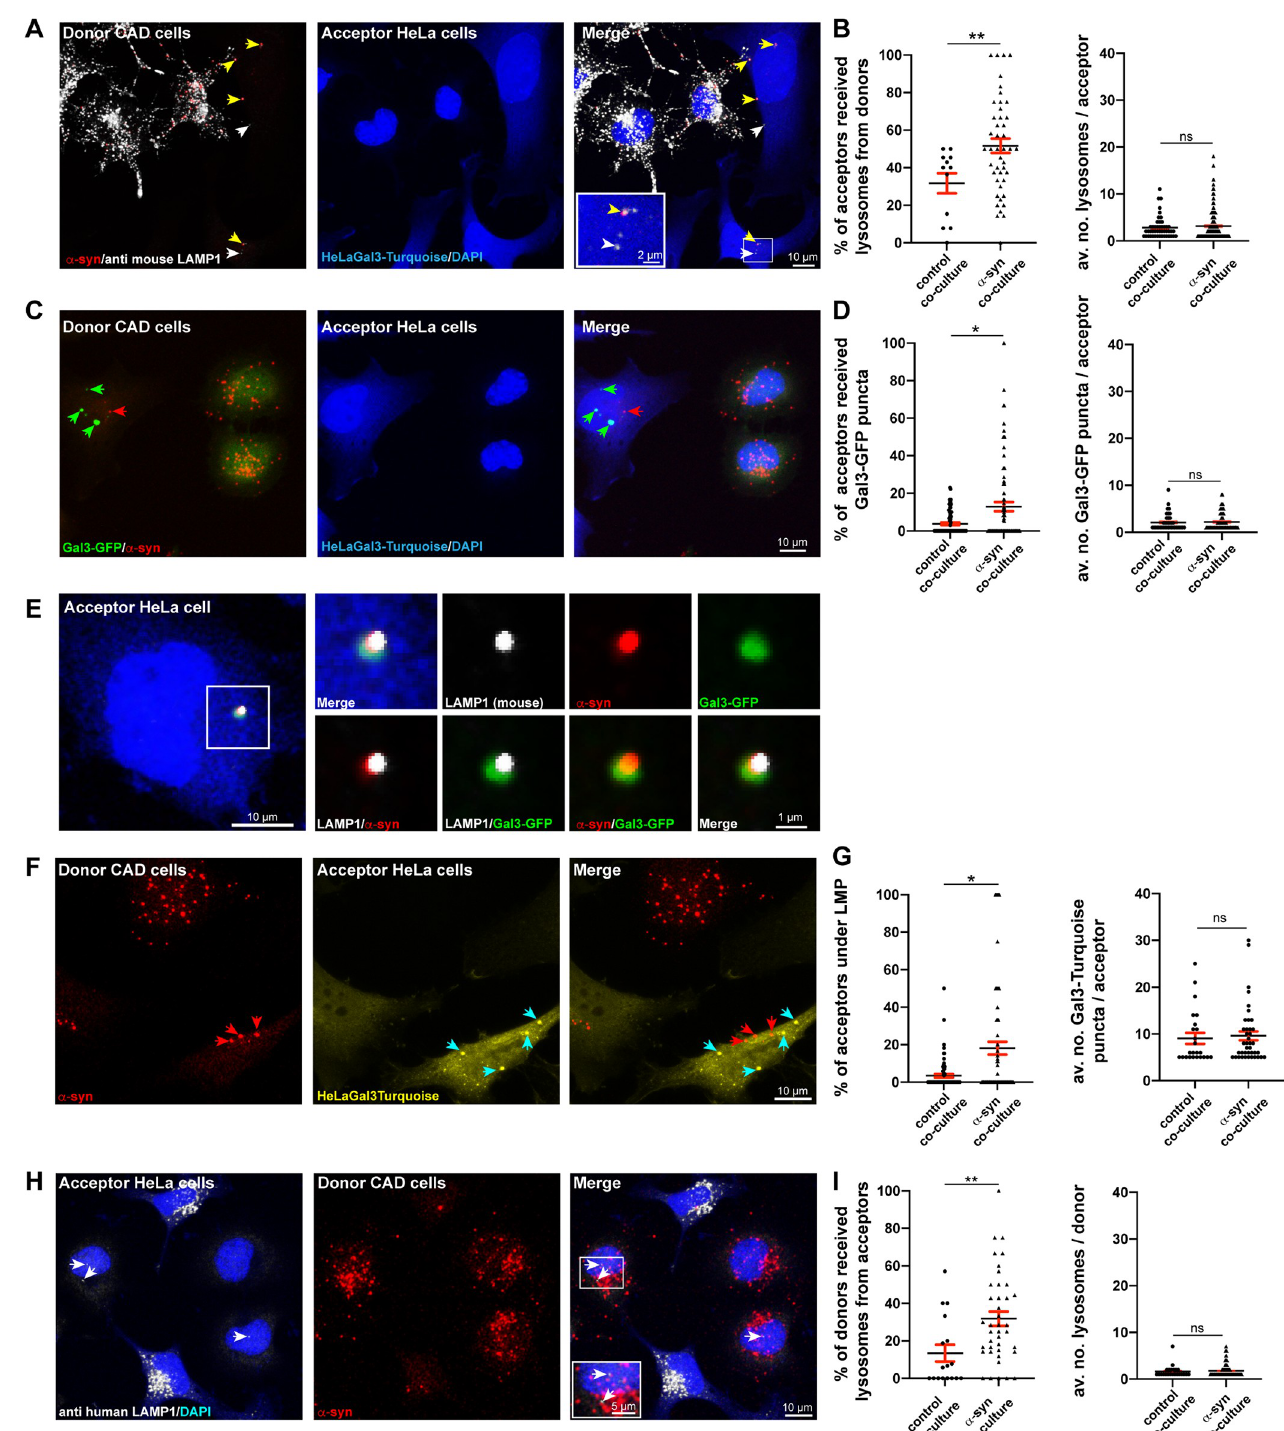
Fig 10. Intercellular lysosome transfer is reciprocal. (A) Representative confocal image of CAD-HeLa coculture where donor mouse CAD cells were treated with Alexa 568–tagged α -syn fibrils (18 hours) and cocultured with acceptor human HeLa stable Gal3-Turquoise cells for 24 hours, labeled for anti-LAMP1 mouse antibody and DAPI. In acceptor HeLa Gal3-Turquoise cells, arrows indicate donors’ lysosomes containing (yellow) or not (white) α -syn fibrils. Inset represents a selected region (white square) of one acceptor cell containing donors’ lysosomes. Scale bar: 10 μ m (for the inset: 2 μ m). (B) % of acceptor HeLa cells that received lysosomes from donor CAD cells in control (32 ± 5%) and in α -syn (52 ± 4%) cocultures (left graph). �� P = 0.006 by 2-tailed t test. Average number of lysosomes transferred from donor to acceptor cells in control (3 ± 0.3) and in α -syn (3 ± 0.3) cocultures (right graph). Mean ± SEM. ns = not